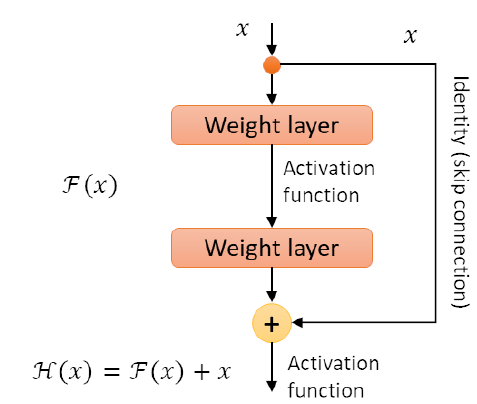
Figure 1. Residual Learning: a building block